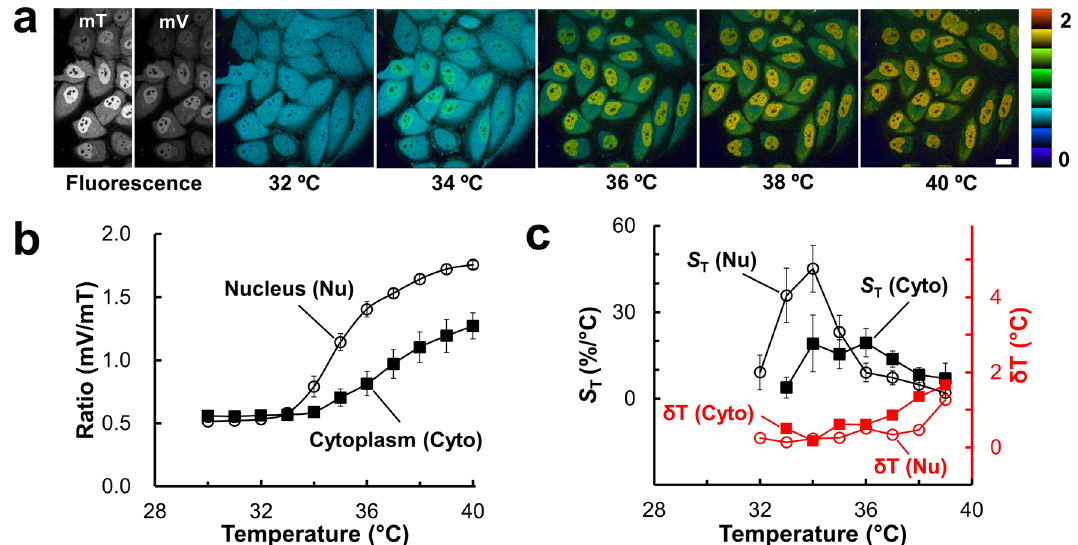
Figure 3. Temperature response of ELP-TEMP stably expressed in live HeLa cells under confocal microscopy observation. ( a ) Confocal fluorescence images and pseudo-colored ratio images of HeLa cells stably expressing ELP-TEMP at various temperatures. ( b ) A plot of fluorescence ratio mV/mT in the nucleus (Nu) and cytoplasm (Cyto) against medium temperature. ( c ) A plot of relative temperature sensitivity ( S T ; left vertical axis) and temperature resolution (δT; right vertical axis) of the Nu or Cyto against medium temperature. The color bar indicates fluorescence ratio mV/mT. Scale bar, 20 µm. Data are mean ± SD ( n =